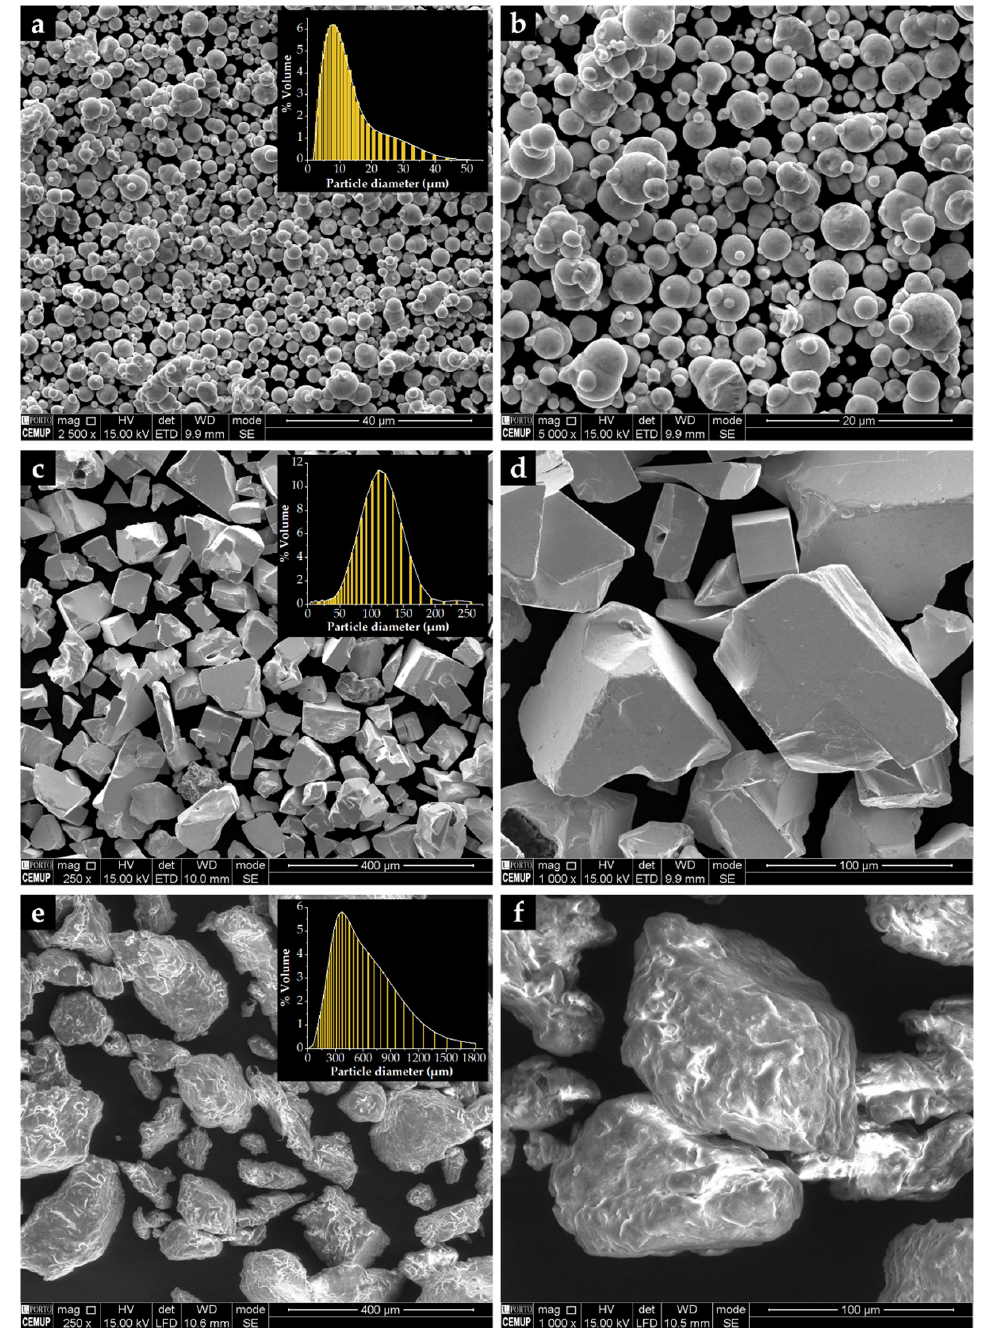
Figure 6. SEM-secondary electron (SE) images of the starting powders: ( a , b ) Fe with round morphology, ( c , d ) polyhedral particles of WC, and ( e , f ) M0101 binder with irregular